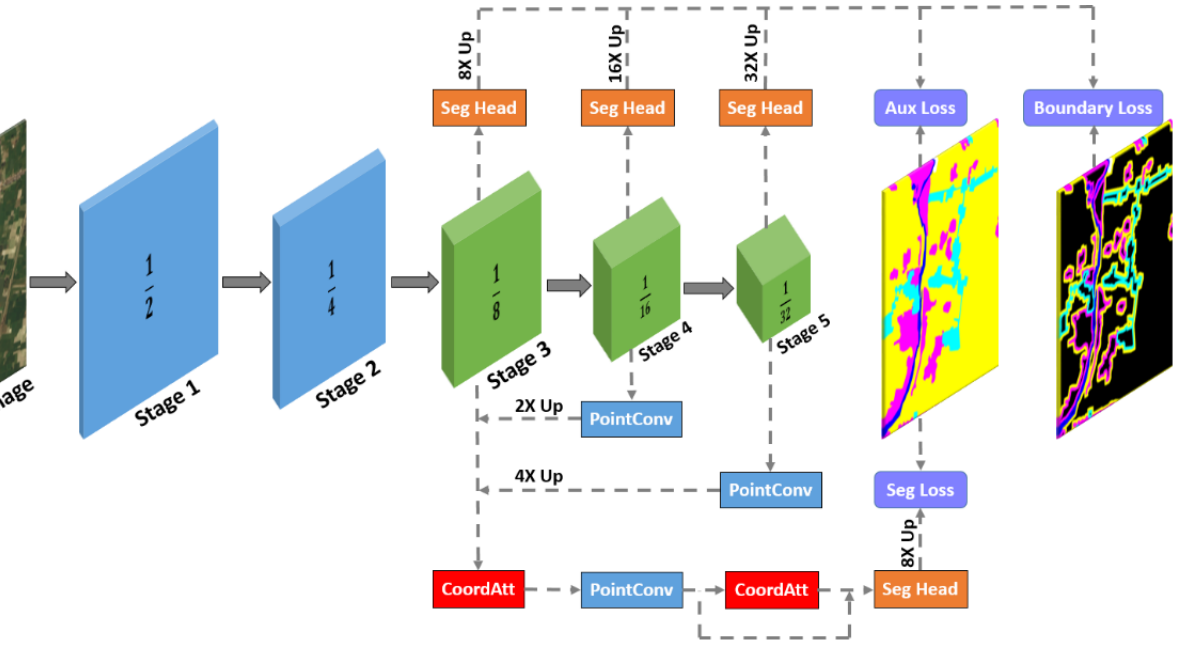
Figure 4. Architecture of MKANet. The blue cuboid represents the 3 × 3 convolution with stride 2, and the green cuboid represents 3 × 3 convolution with stride 2 plus one or more MKA